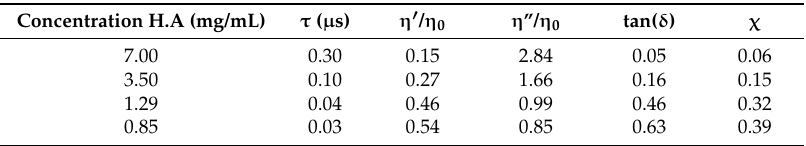
Table 5. Factor χ